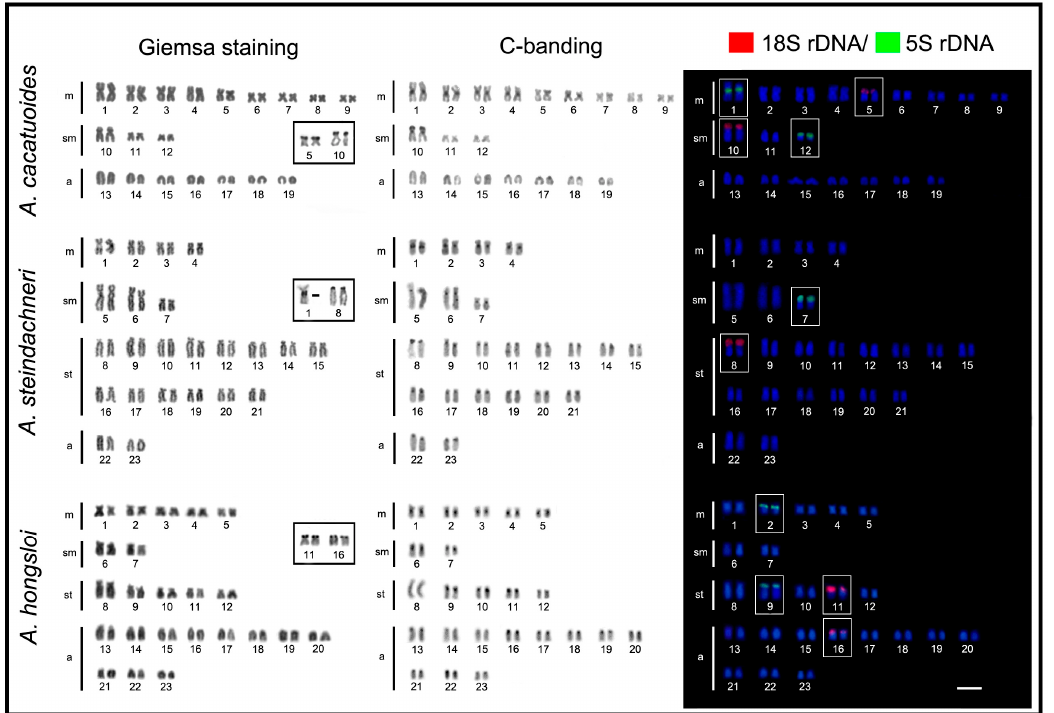
Figure 1. Karyotypes of Apistogramma cacatuoides , Apistogramma steindachneri , and Apistogramma hongsloi , arranged after Giemsa-stained, C-banding, Ag-NOR, and fluorescence in situ hybridization (FISH) with 18S rDNA (red) and 5S rDNA (green) probes. The Ag-NOR-, 18S-, and 5S-bearing chromosomes are boxed. Bar = 5 μ m.